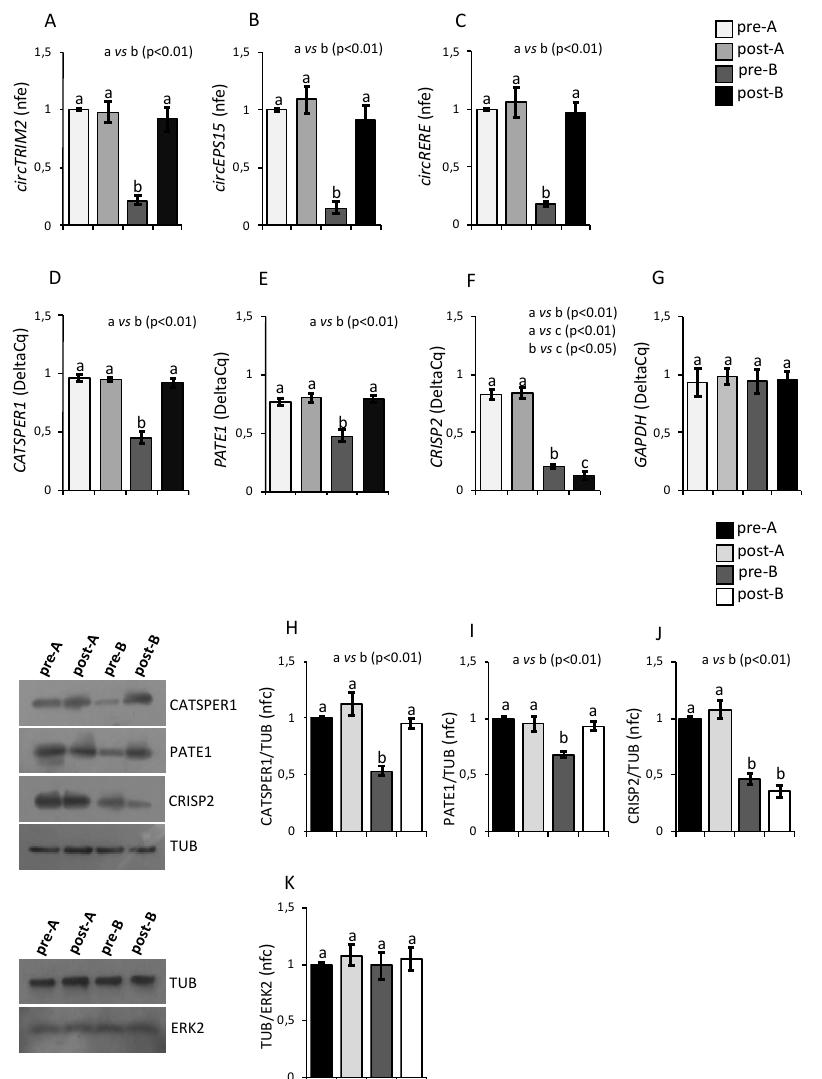
Figure 3. Expression of CATSPER1, PATE1, CRISP2 and circRNAs in Asthenozoospermic Sperm after an oral Amino Acid Supplementation. ( A – F ) Expression of circRNAs and mRNAs in A-spermatozoa and B-spermatozoa collected from asthenozoospermic patients before (pre-A; pre-B) and after (post-A; post-B) an oral amino acid supplementation therapy by qRT-PCR. ( A ) circTRIM2, ( B ) circEPS15, ( C ) circRERE, ( D ) CATSPER1 , ( E ) PATE1 and ( F ) CRISP2 were normalized by using GAPDH as the reference gene. ( G ) Expression of GAPDH mRNAs in A-spermatozoa and B-spermatozoa collected from asthenozoospermic patients before (pre-A; pre-B) and after (post-A; post-B) an oral amino acid supplementation therapy by qRT-PCR. GAPDH was normalized by using PCNA as the reference gene. CircRNAs data were expressed as normalized fold expression (n.f.e.); mRNAs data were expressed as normalized quantification cycle for PCR (Delta-Cq). All data were reported as mean value ± S.E.M. Experimental groups with statistically significant differences ( p < 0.05; p < 0.01) were indicated with different letters; the experimental groups without statistically significant differences were indicated with the same letter. ( H – K ) Western blot analysis of CATSPER1 ( H ), PATE1 ( I ), CRISP2 ( J ) and Tubulin ( K ) proteins in A-spermatozoa and B-spermatozoa collected from asthenozoospermic patients before (pre-A; pre-B) and after (post-A; post-B) an oral amino acid supplementation therapy. In ( H – J ), signals were quantified by densitometry analysis and normalized against Tubulin. In ( K ), Tubulin signals were quantified by densitometry analysis and normalized against ERK2. Data were expressed as normalized fold change (n.f.c) and reported as mean ± SEM. Experimental groups with statistically significant differences ( p < 0.01) were indicated with different letters; the experimental groups without statistically significant differences were indicated with the same